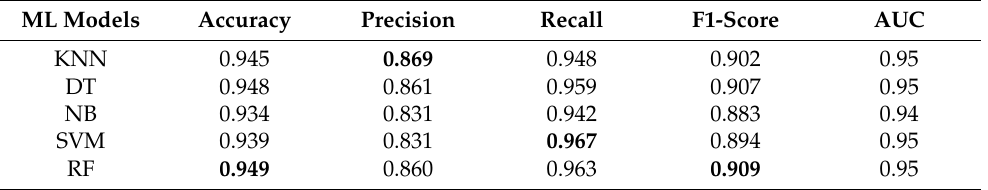
Table 4. Performance Prediction of all ML Models for Amputation.